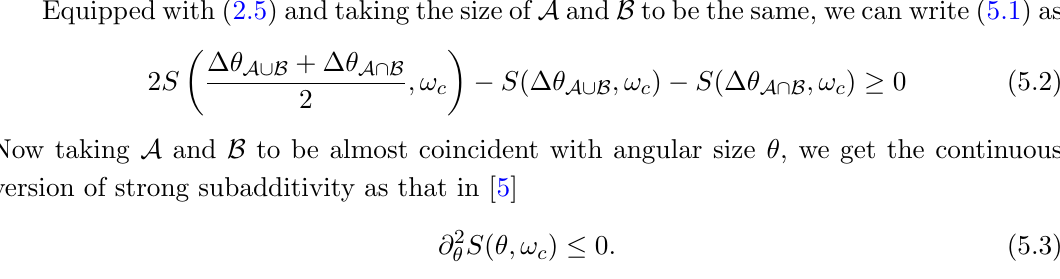
Figure 9 . The causal diamond for strong subadditivity. A is the red interval and B is the blue one. The red diamond is D [ A ], the blue diamond is D [ B ], the intersection of red and blue diamonds is D [ A \ B ] and the whole diamond is D [ A [ B